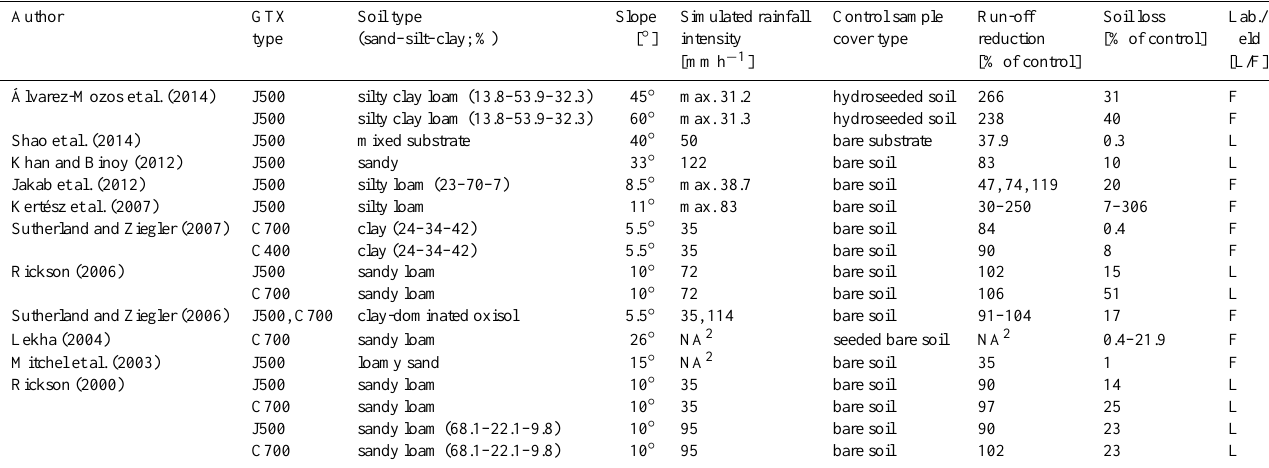
Table 1. Overview of studies investigating the impact of J500 (jute) (500gm − 2 ) and C400, C700 (coir) (400; 700gm − 2 ) GTXs on surface run-off and soil erosion by water since 2000 1 .